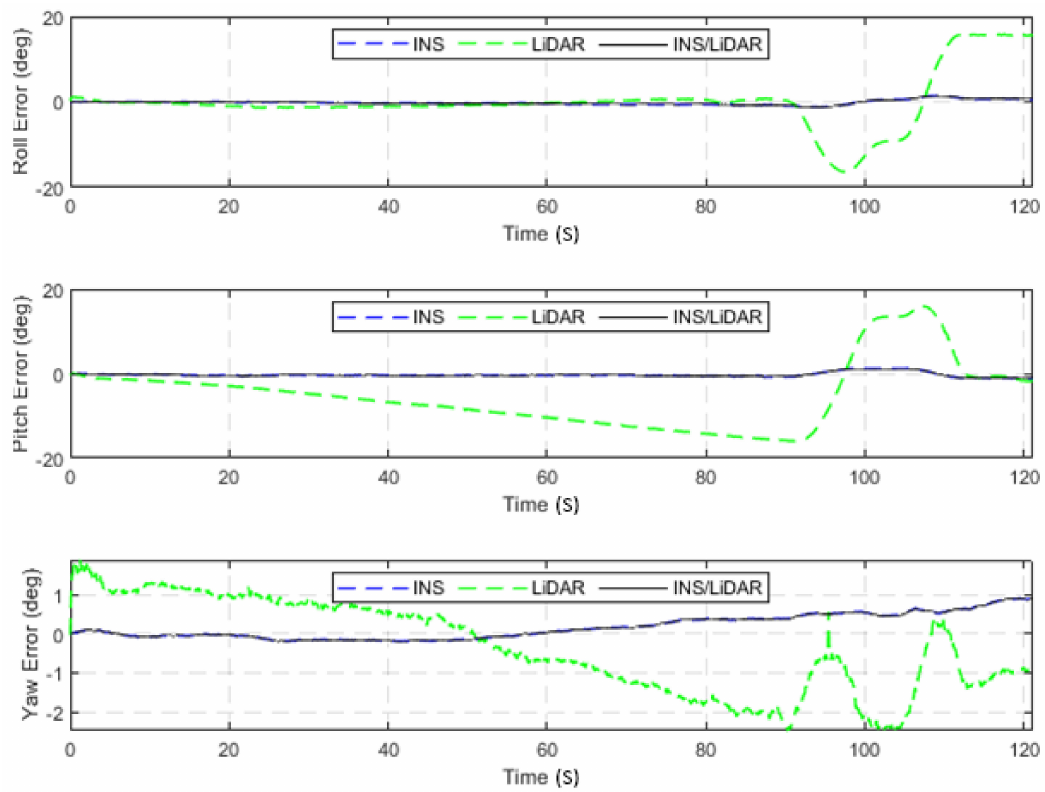
Figure 17. D-42—complete GNNS signal outage: errors of attitude angles (roll, pitch, and